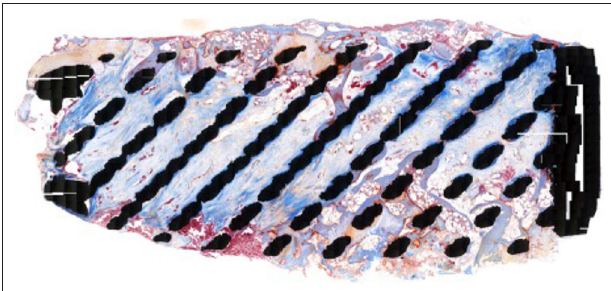
FIGURE 6 | Masson Goldner Trichrome stained specimen, 20x magnification: In this staining the lamellar bone is colored light blue and young woven bone and osteoid has a red